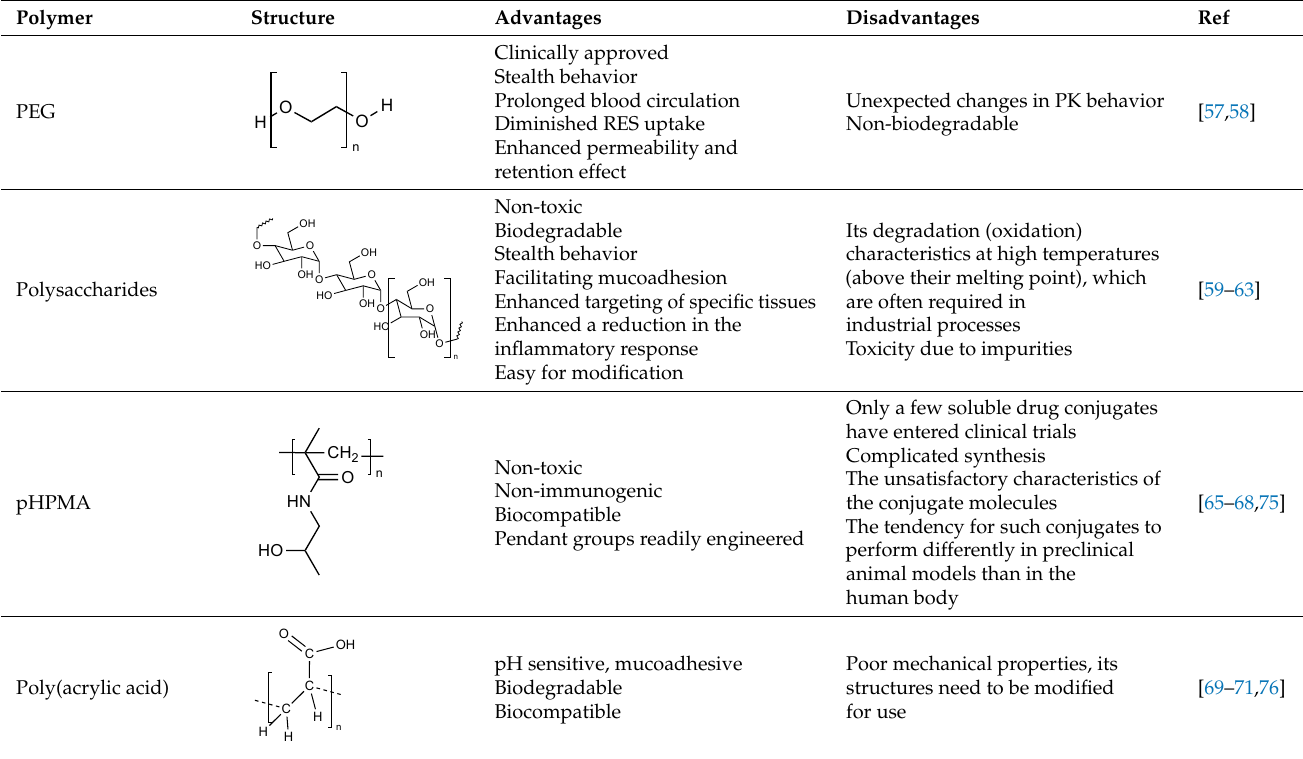
Table 1. Features of hydrophilic polymers commonly used for polymeric micelles.